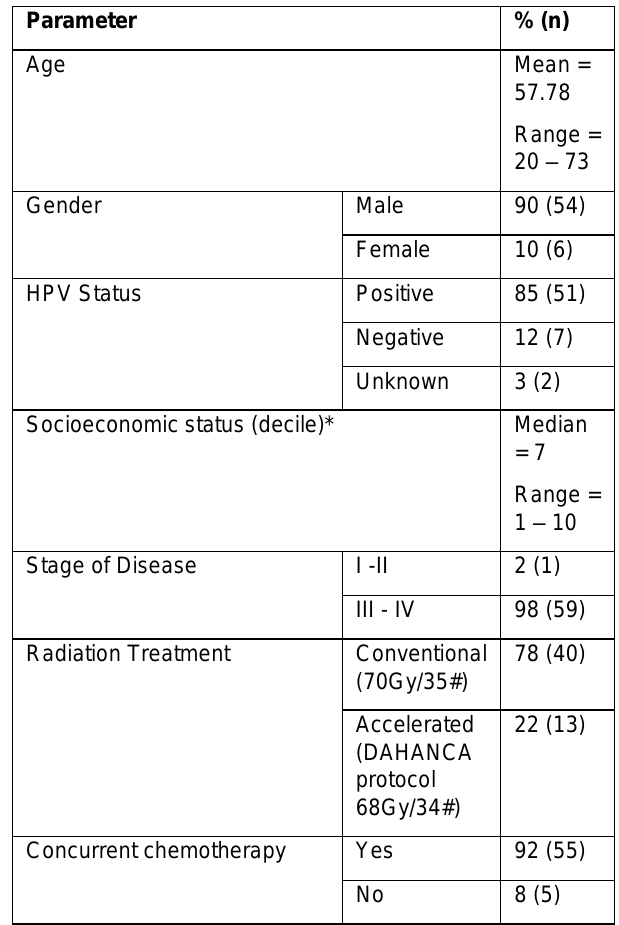
Table 1. Participant Demographics (n =